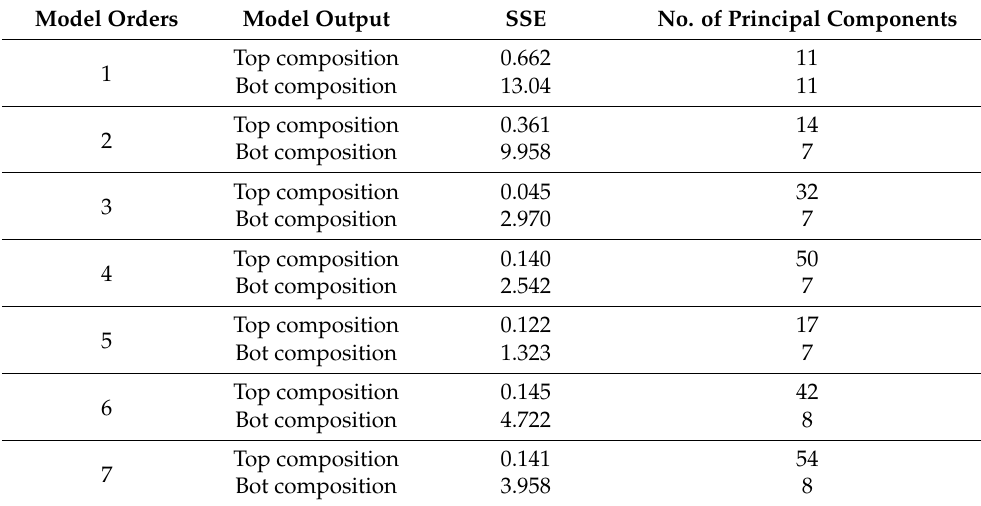
Table 3. Number of principal components and SSE on testing data of different dynamic PCR models.